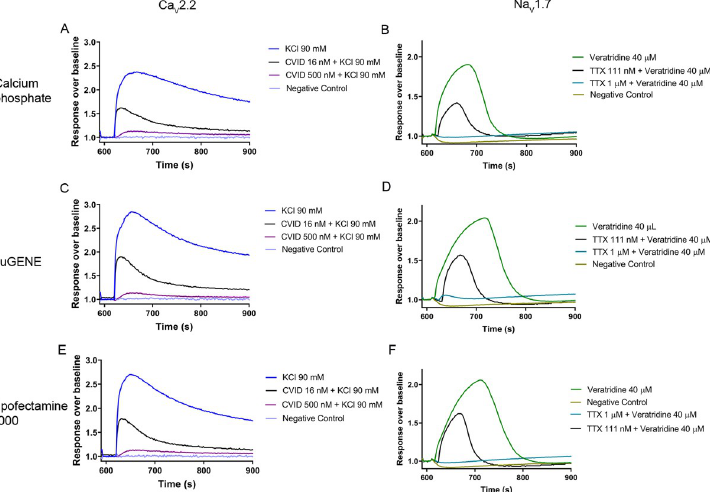
Fig 5. Representative Ca 2+ fluorescence responses for Ca V 2.2 (A, C, E) and Na V 1.7 (B, D, F), transfected by calcium phosphate-, FuGENE-, and Lipofectamine 3000 measured in a FLIPR TETRA . The KCl-evoked Ca 2+ fluorescence responses of Ca V 2.2 over baseline for calcium phosphate-, FuGENE-, and Lipofectamine 3000 were 1.3 ± 0.0 (A), 1.7 ± 0.1 (C), and 1.5 ± 0.1 (E), respectively. The addition of 500 nM, and 16 nM CVID blocked the fluorescence response by 99.4 ± 1.8%, and 51.2 ± 3.3%, respectively, for calcium phosphate (A), 100.8 ± 0.9% and 50.1 ± 1.2%, respectively, for FuGENE (C), and 99.1 ± 1.0% and 49.5 ± 2.1%, respectively, for Lipofectamine 3000 (E). The veratridine-evoked Ca 2+ fluorescence responses of Na V 1.7 over baseline for calcium phosphate-, FuGENE-, and Lipofectamine 3000-mediated transfetion were 0.9 ± 0.0 (B), 1.2 ± 0.1 (D), and 1.1 ± 0.1 (E), respectively. Addition of 1 μ M, and 111 nM TTX blocked the fluorescence response by 98.9 ± 1.8% and 53.8 ± 1.6%, respectively, for calcium phosphate (B), 99.8 ± 0.4% and 54.2 ± 2.0%, respectively, for FuGENE (D), and 99.4 ± 1.1% and 51.2 ± 2.3%, respectively, for Lipofectamine 3000 (F). Data are represented as mean ± SEM (N = 3 independent experiments conducted in triplicate).